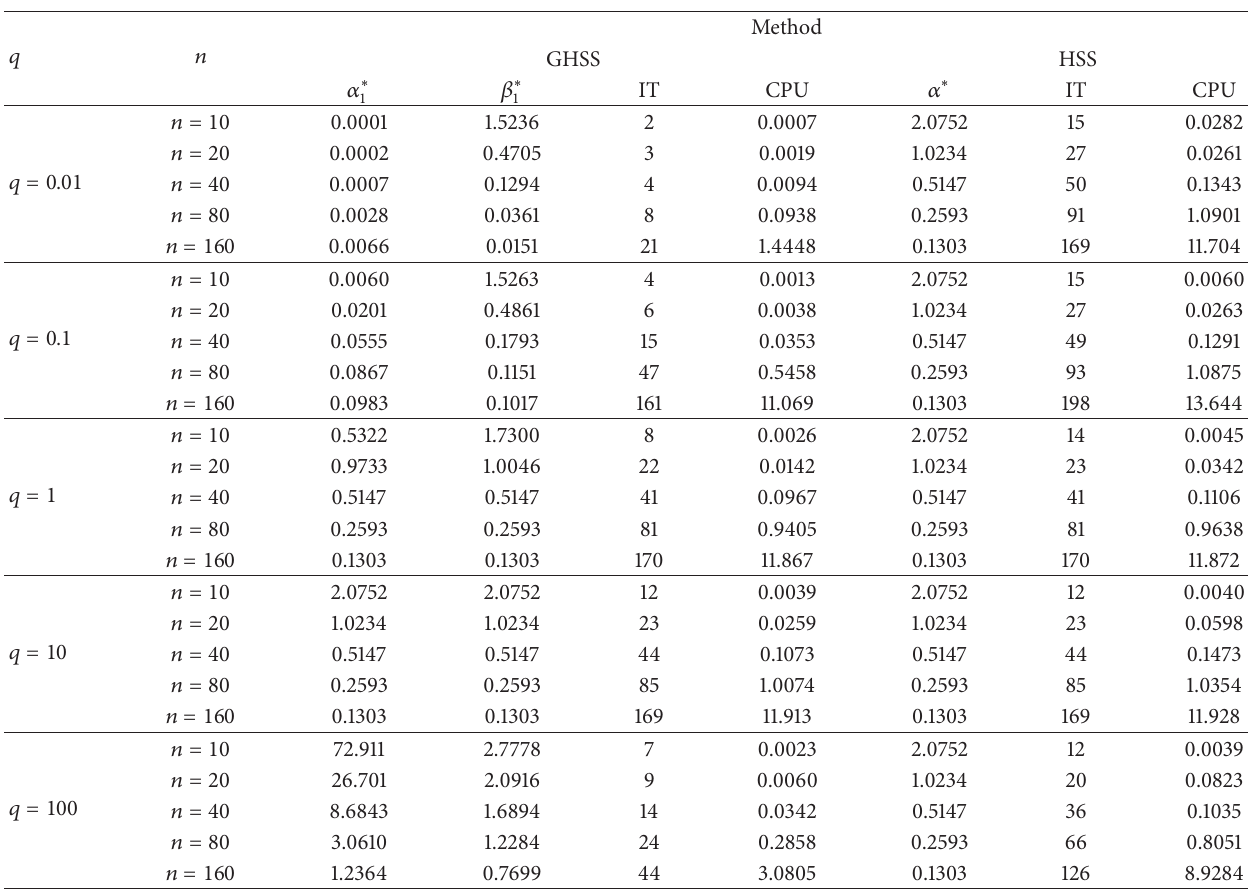
Table 2: Numerical results for GHSS and HSS with the theoretical quasi-optimal iteration